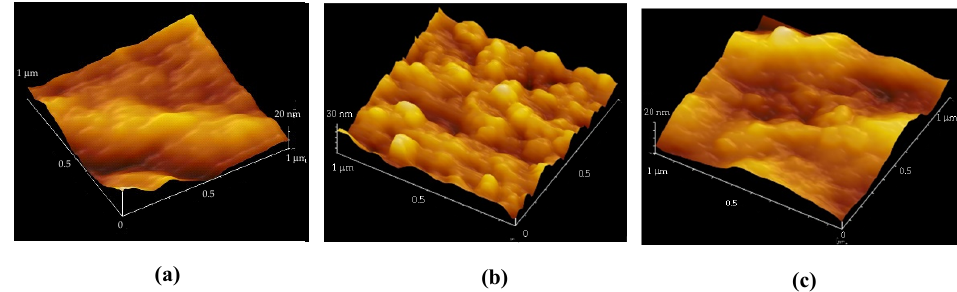
Figure 2. AFM images. ( a ) Sample with low piezoelectricity. ( b ) Sample with poor mechanical properties and high piezoelectricity (previously reported). ( c ) Developed PLLA fiber with good mechanical and piezoelectric properties for sensing.